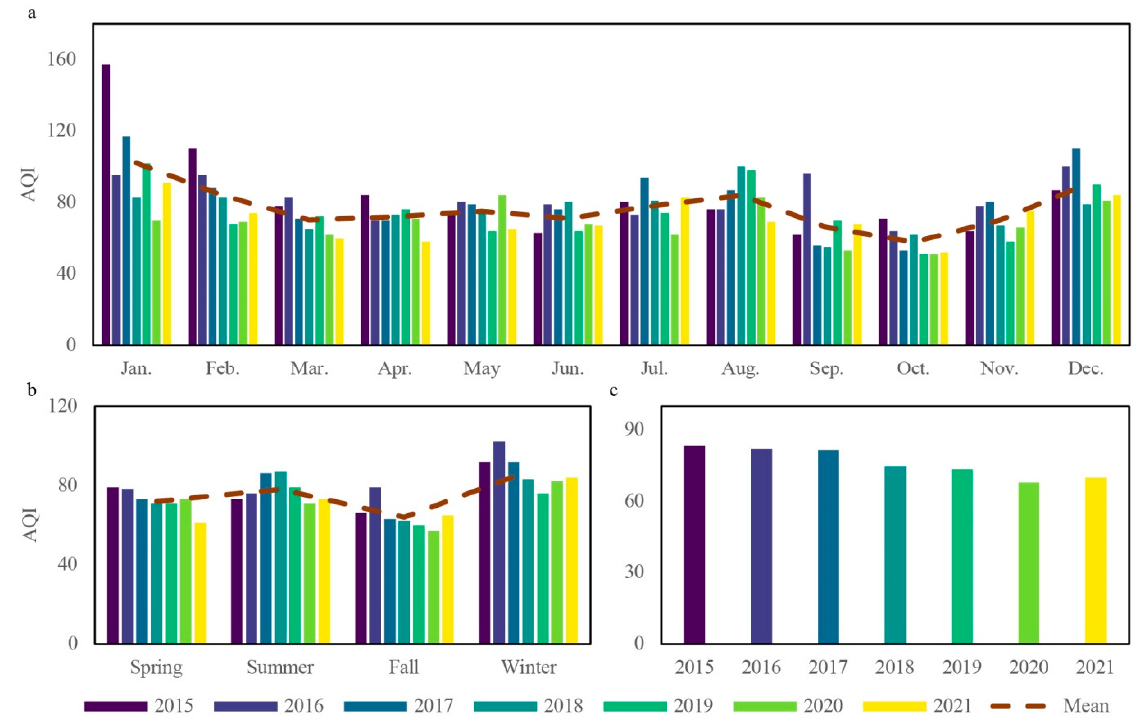
Figure 5. Temporal variation of AQI on the scale of months ( a ), seasons ( b ), and years ( c ).